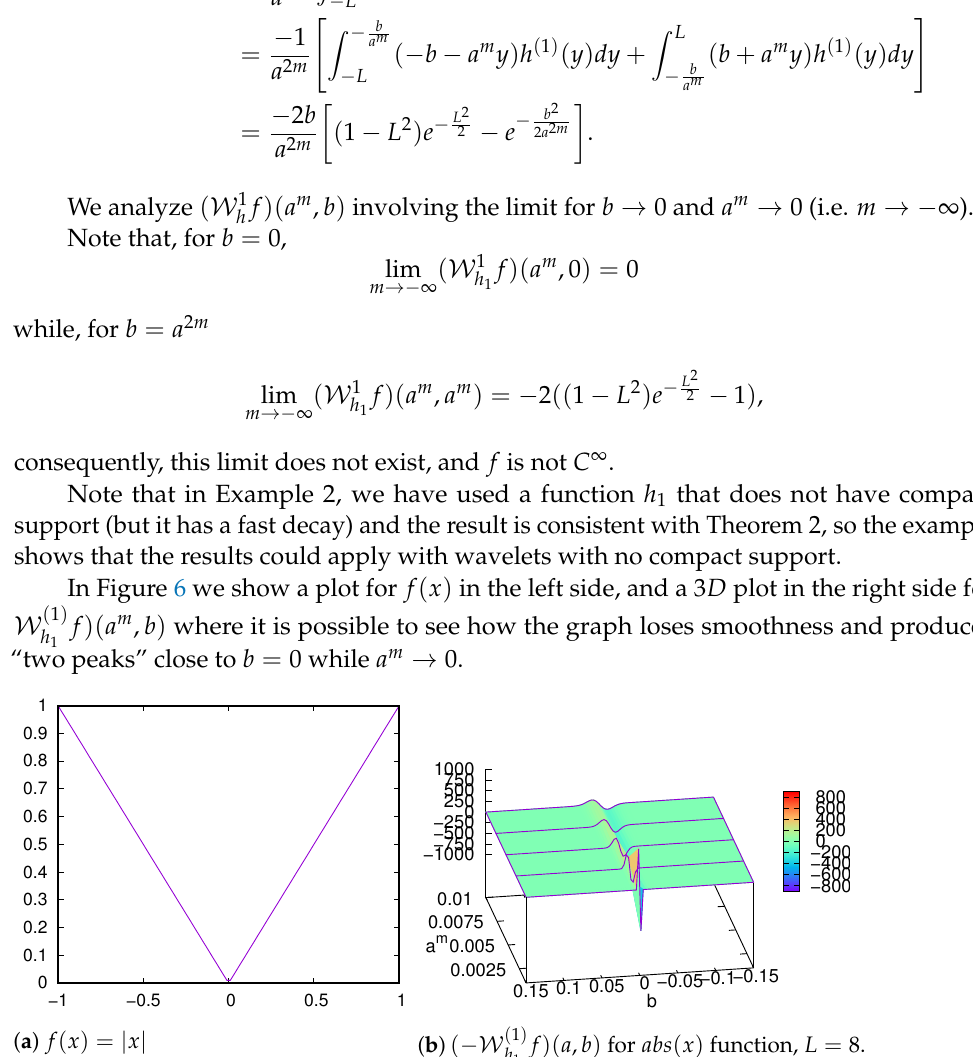
Figure 6. f ( x ) and W